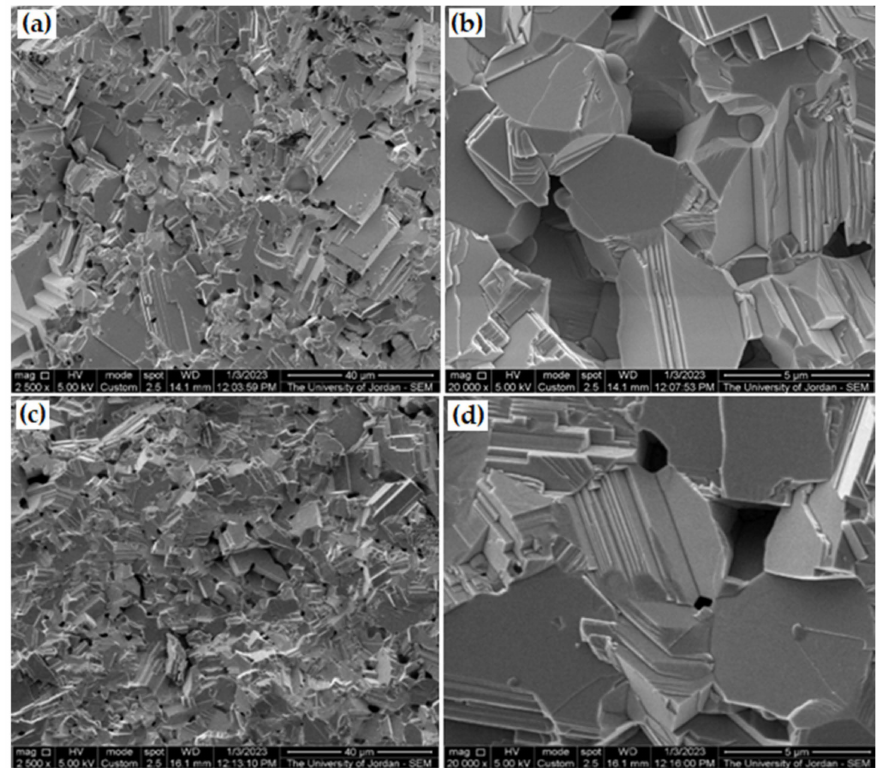
Figure 10. SEM micrographs (SEI) of sintered samples’ fractured surfaces: ( a ) powder of galena of 15 min milling time at 2500 × , ( b ) same of ( a ) at 20,000 × , ( c ) sample of water separated galena powder at 2500 × , and ( d ) same of ( c ) at 20,000 ×